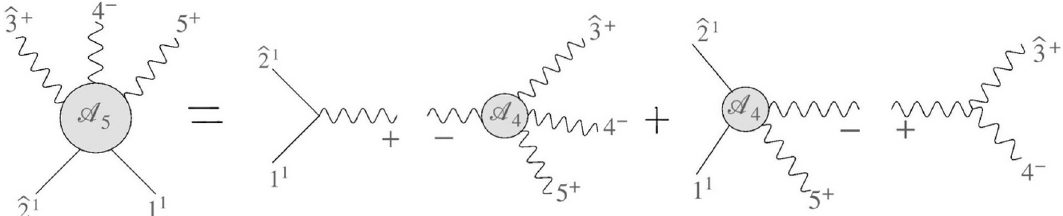
Figure 4 . Five-particle amplitude in Higgsed